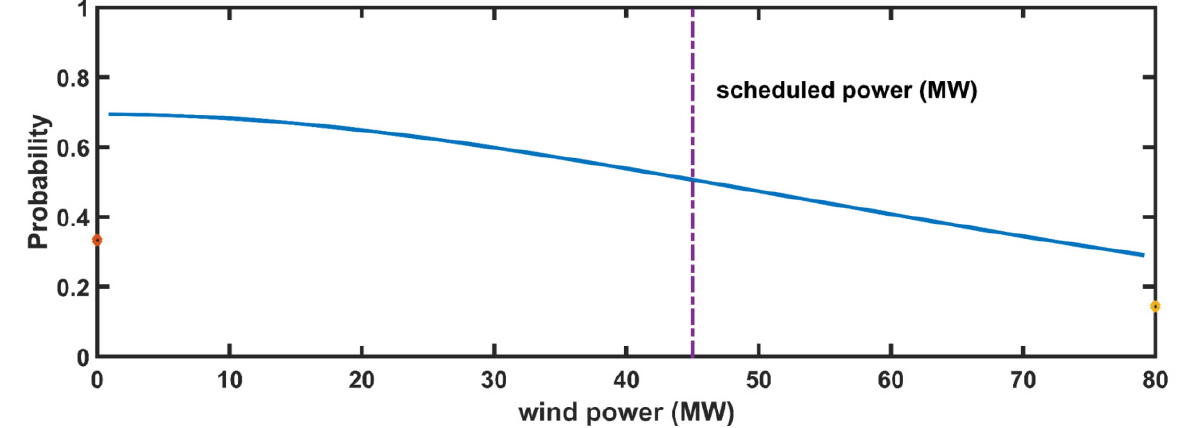
Figure 4. Probability distribution for the power output of 80 MW wind farm.